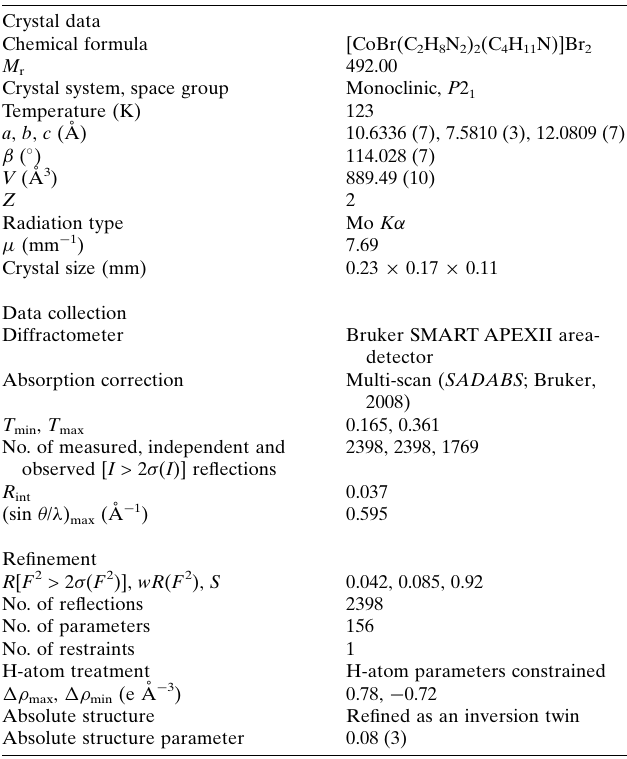
Table 2 Experimental